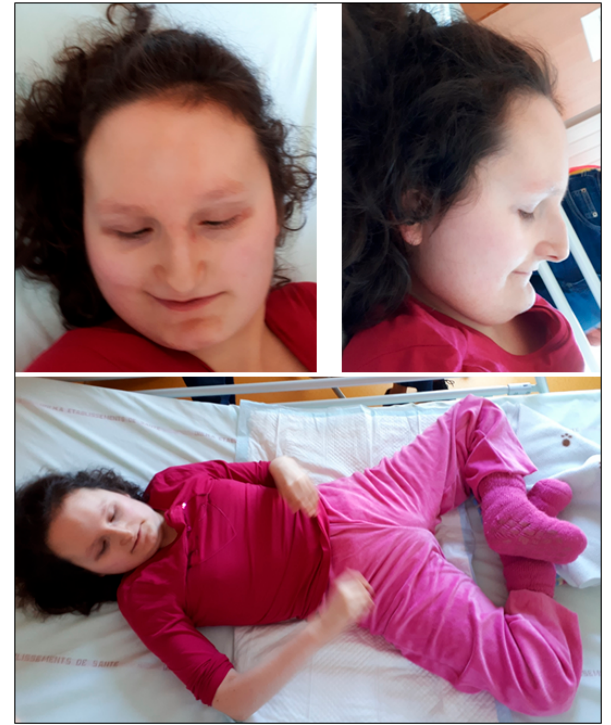
Figure 1. Photography of patient 1 (Decipher 286390) at 20 years old. She has a high and broad forehead, sparse lateral eyebrows, long nose with prominent nasal bridge, short and smooth philtrum, thin lips, prominent chin with horizontal crease, quite large mouth, and a short neck. There is a large abduction and an external rotation of the two